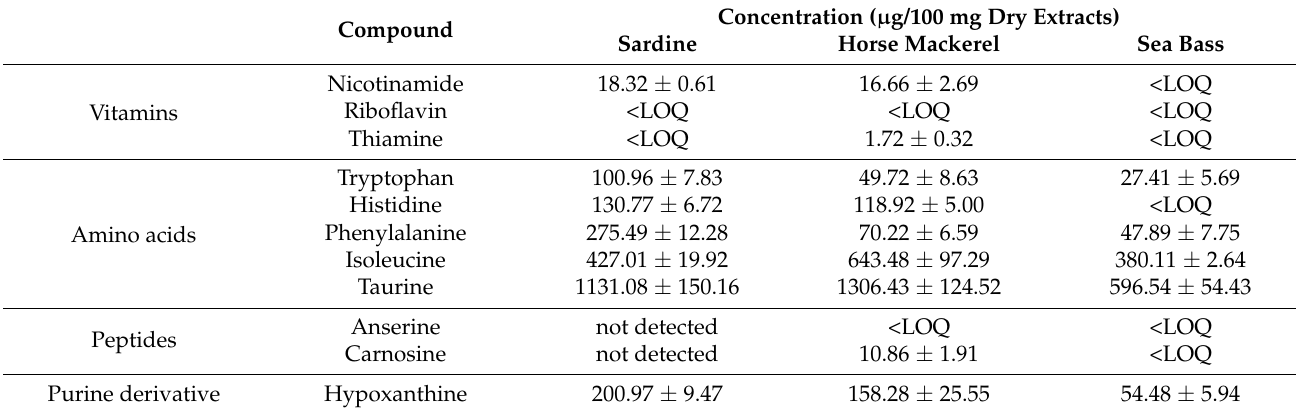
Table 3. Concentrations of the water-soluble compounds ( µ g/100 mg of freeze-dried extracts) identified in sardine, horse mackerel and sea bass roe-derived aqueous extracts. Data are shown as arithmetic means ± SD (n =